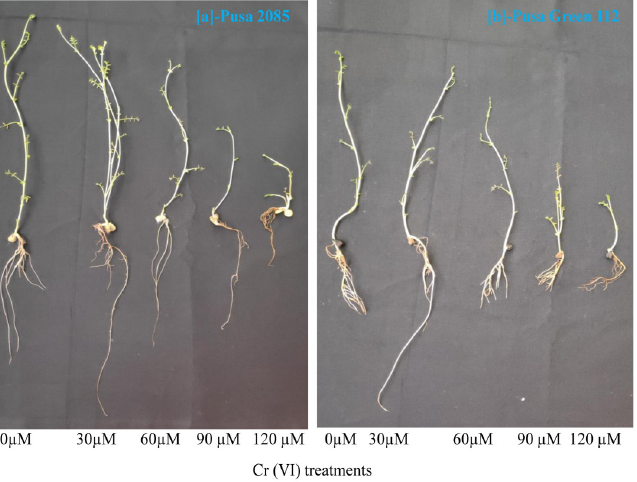
Fig 3. Effects of various chromium (Cr) concentrations on the morpho-physiological traits of two chickpea varieties under hydroponic conditions. (a) Pusa 2085. (b) Pusa Green 112.